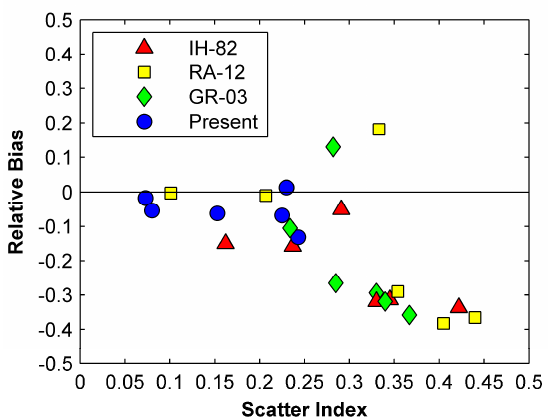
Figure 14. Scatter diagram between the relative bias and scatter index for the peak onshore and offshore orbital velocities using the four employed formulas.